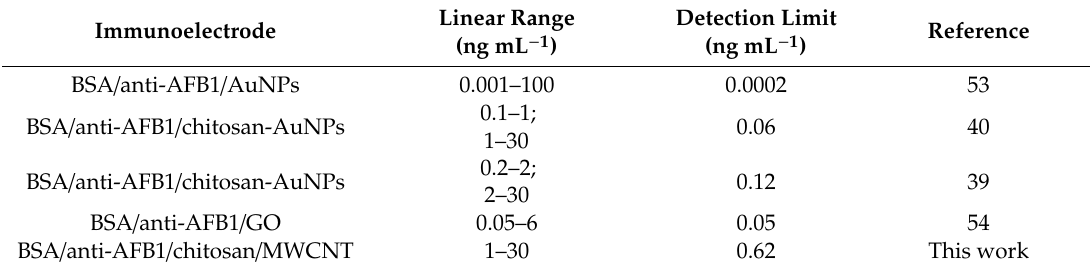
Table 1. Comparison of analytical performance of modified electrodes for detection of aflatoxin B1 .